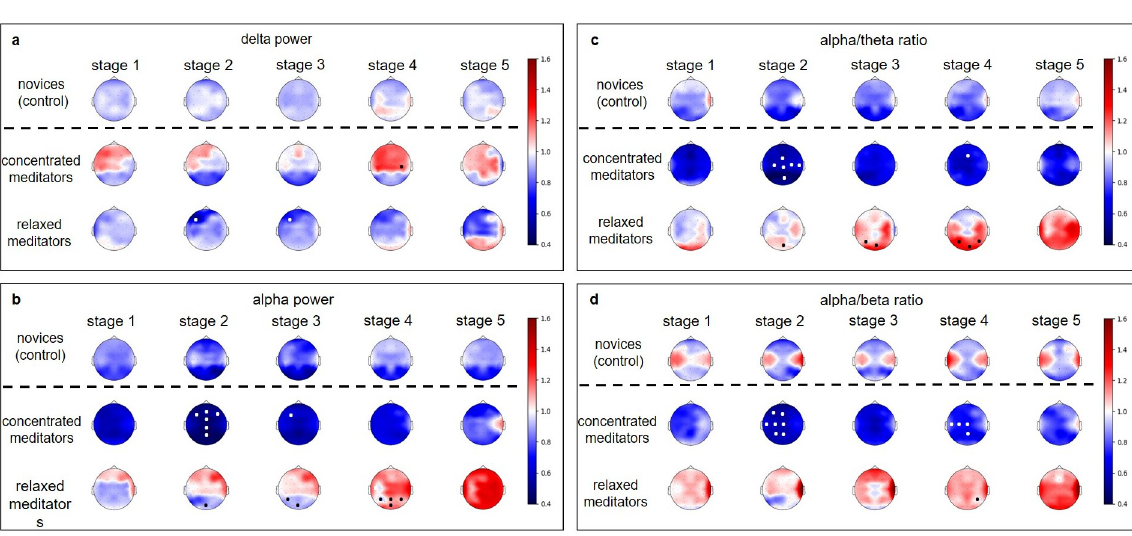
Fig 9. Changes of EEG-derived indices in the “relaxed” and “concentrated” experienced meditators and novices. All values were normalized to the individual baseline. Data are presented as a group median value. We have used a common colorbar for all EEG indices and groups to make it easier to compare effects. Dots mark significant (p < 0.05) difference between Experienced meditators group and Novices according to the one- way ANOVA test, followed by the post hoc Tuckey’s test. The colors of the dots were chosen to improve visibility and don’t carry any additional